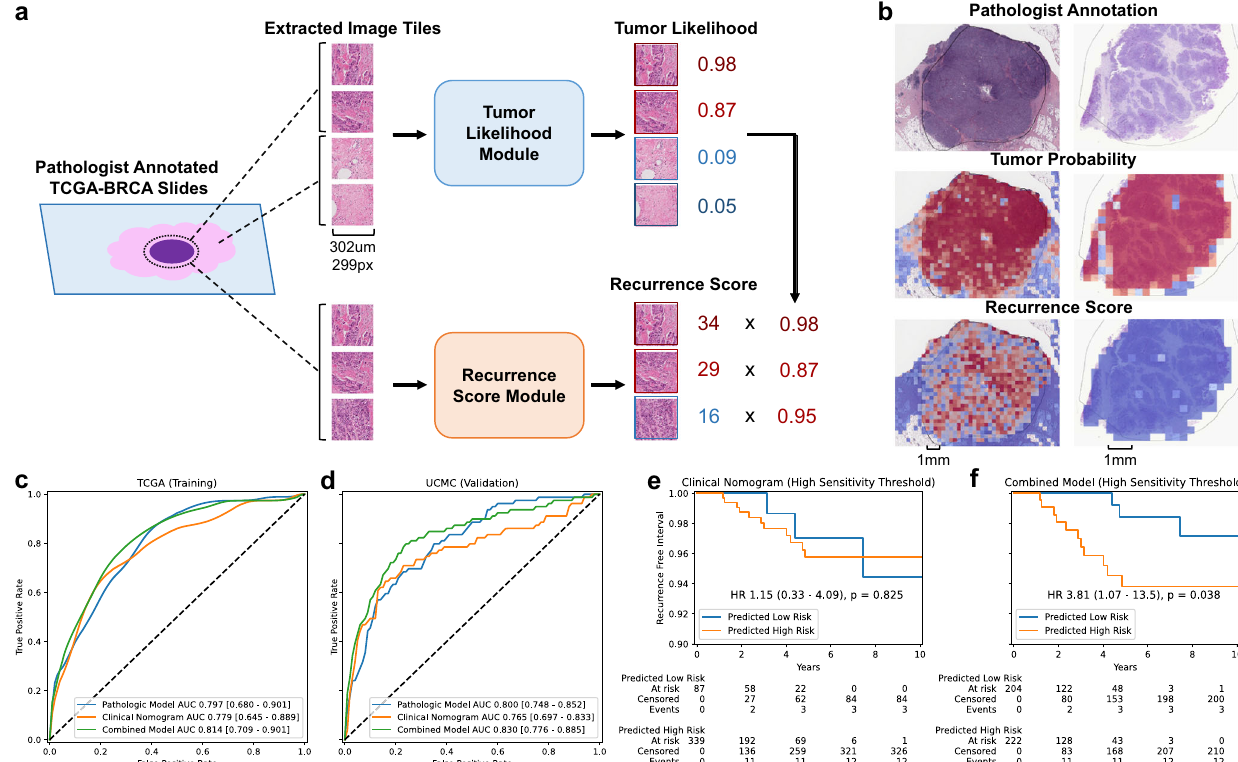
Fig. 1 Overview of model architecture and results. a Xception-based deep learning models were trained on 1,039 patients from TCGA to allow for unsupervised predictions on external data. One model was trained to identify image tiles within pathologist annotation of tumor versus background image tiles ( b, middle). The second model was trained to predict a research version of the 21-gene recurrence score calculated from gene expression data from the annotated tumor regions from TCGA ( b, bottom). Finally, a combined clinical / pathologic model was developed by fi tting a logistic regression to deep learning model predictions and the University of Tennessee clinical nomogram predictions. c Average patient-level AUROC for prediction of high-risk recurrence score in HR + /HER2- patients from TCGA on three-fold cross- validation ( n = 535); the combined model AUROC was signi fi cantly higher than the clinical nomogram in two of three folds. d Patient-level AUROC for prediction of high-risk recurrence score in the UCMC cohort ( n = 427); the combined model AUROC was signi fi cantly higher that the clinical nomogram in this cohort. e, f Kaplan-Meier curves illustrate recurrence-free interval in patients from the UCMC validation cohort predicted to have a high-risk Oncotype score using high-sensitivity thresholds (derived from TCGA) for each model. TCGAThe Cancer Genome Atlas. AUC / AUROC Area Under the Receiver Operating Characteristic Curve, HR Hormone Receptor, UCMC University of Chicago Medical